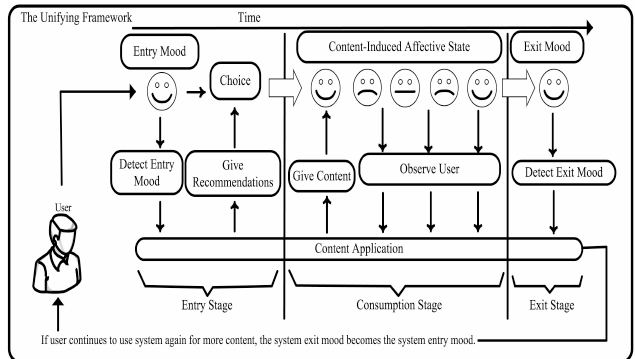
Figure 1. Unifiying Framework (Tkal č i č et al. [25])